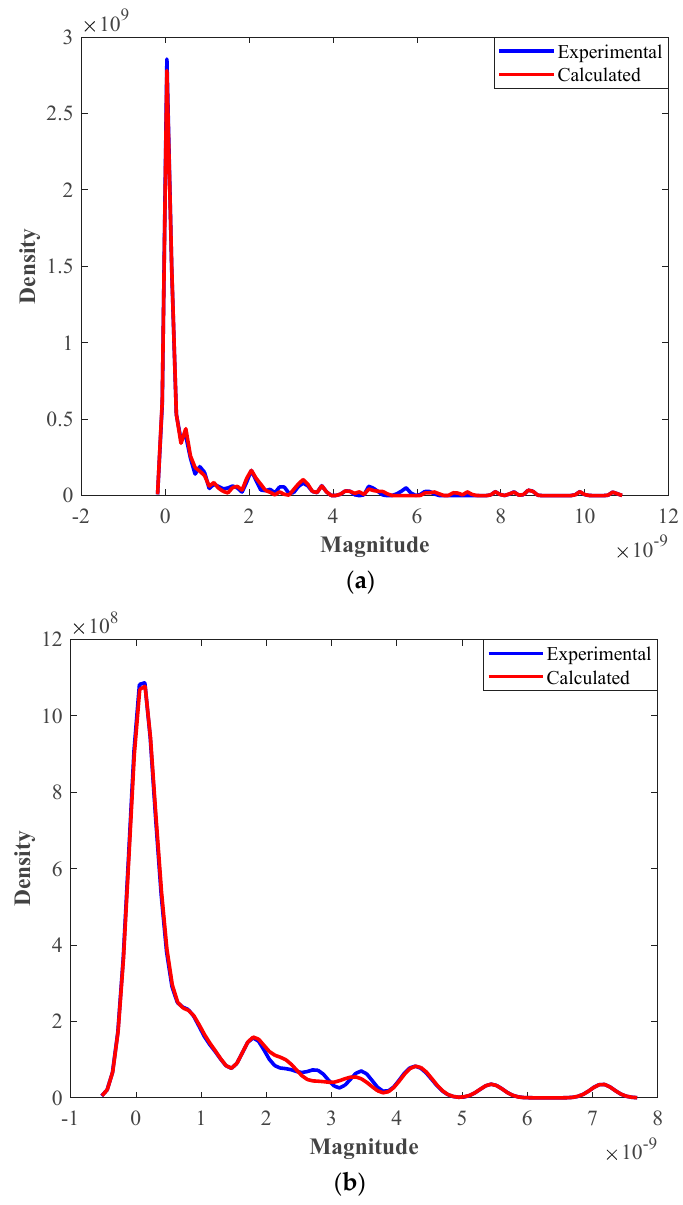
Figure 4. The kernel density estimation graphs for ( a ) internal and ( b ) external groups.